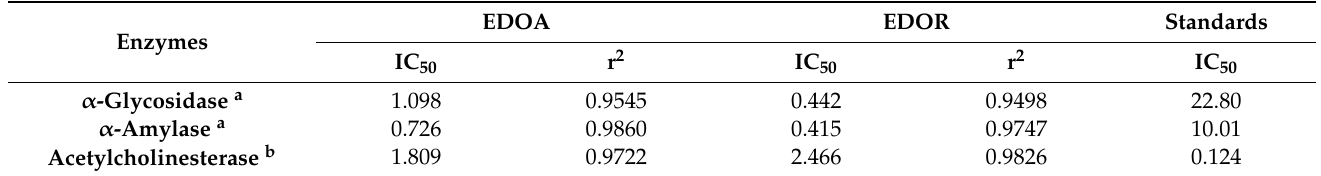
Table 5. The enzyme inhibition (IC 50 , µ g/mL) of EDOA and EDOR against α -amylase, α -glycosidase, and